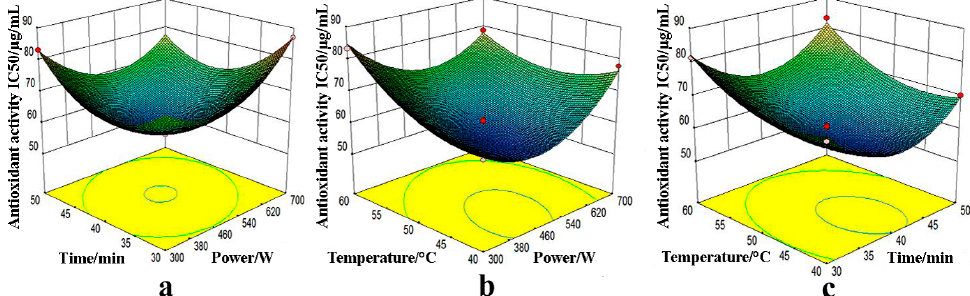
Figure 5. Interaction effects of microwave power and extraction time ( a ); microwave power and extraction temperature ( b ); extraction temperature and time ( c ) on antioxidant activities.